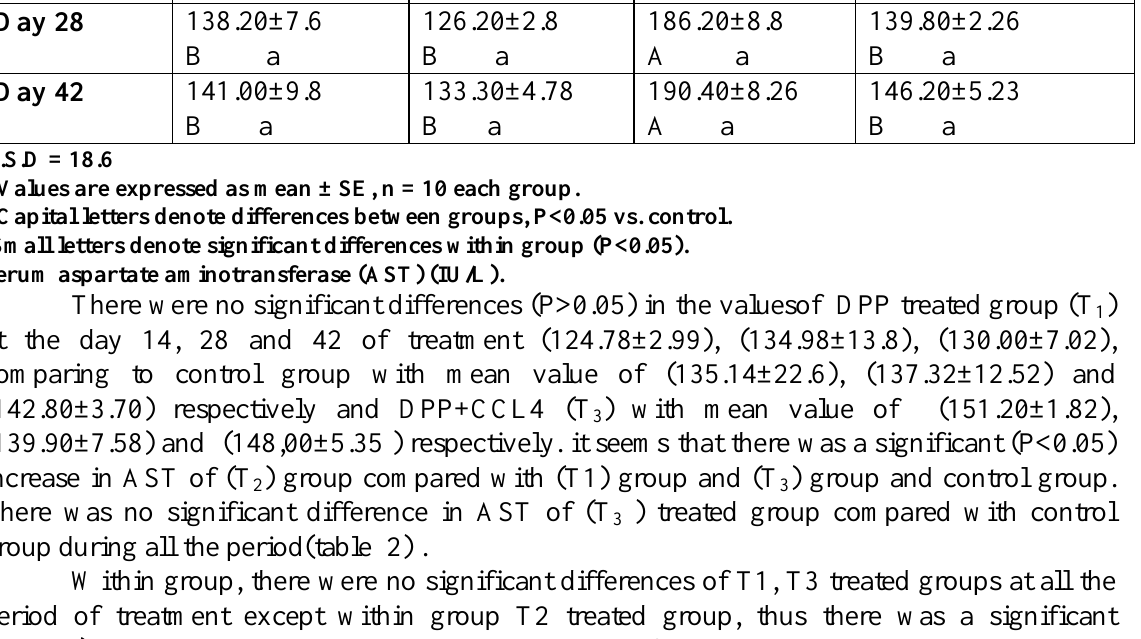
Table (2): Effect of DPP, CCL4 and DPP plus CCL4 on AST activity (IU/L) of adult male rats.